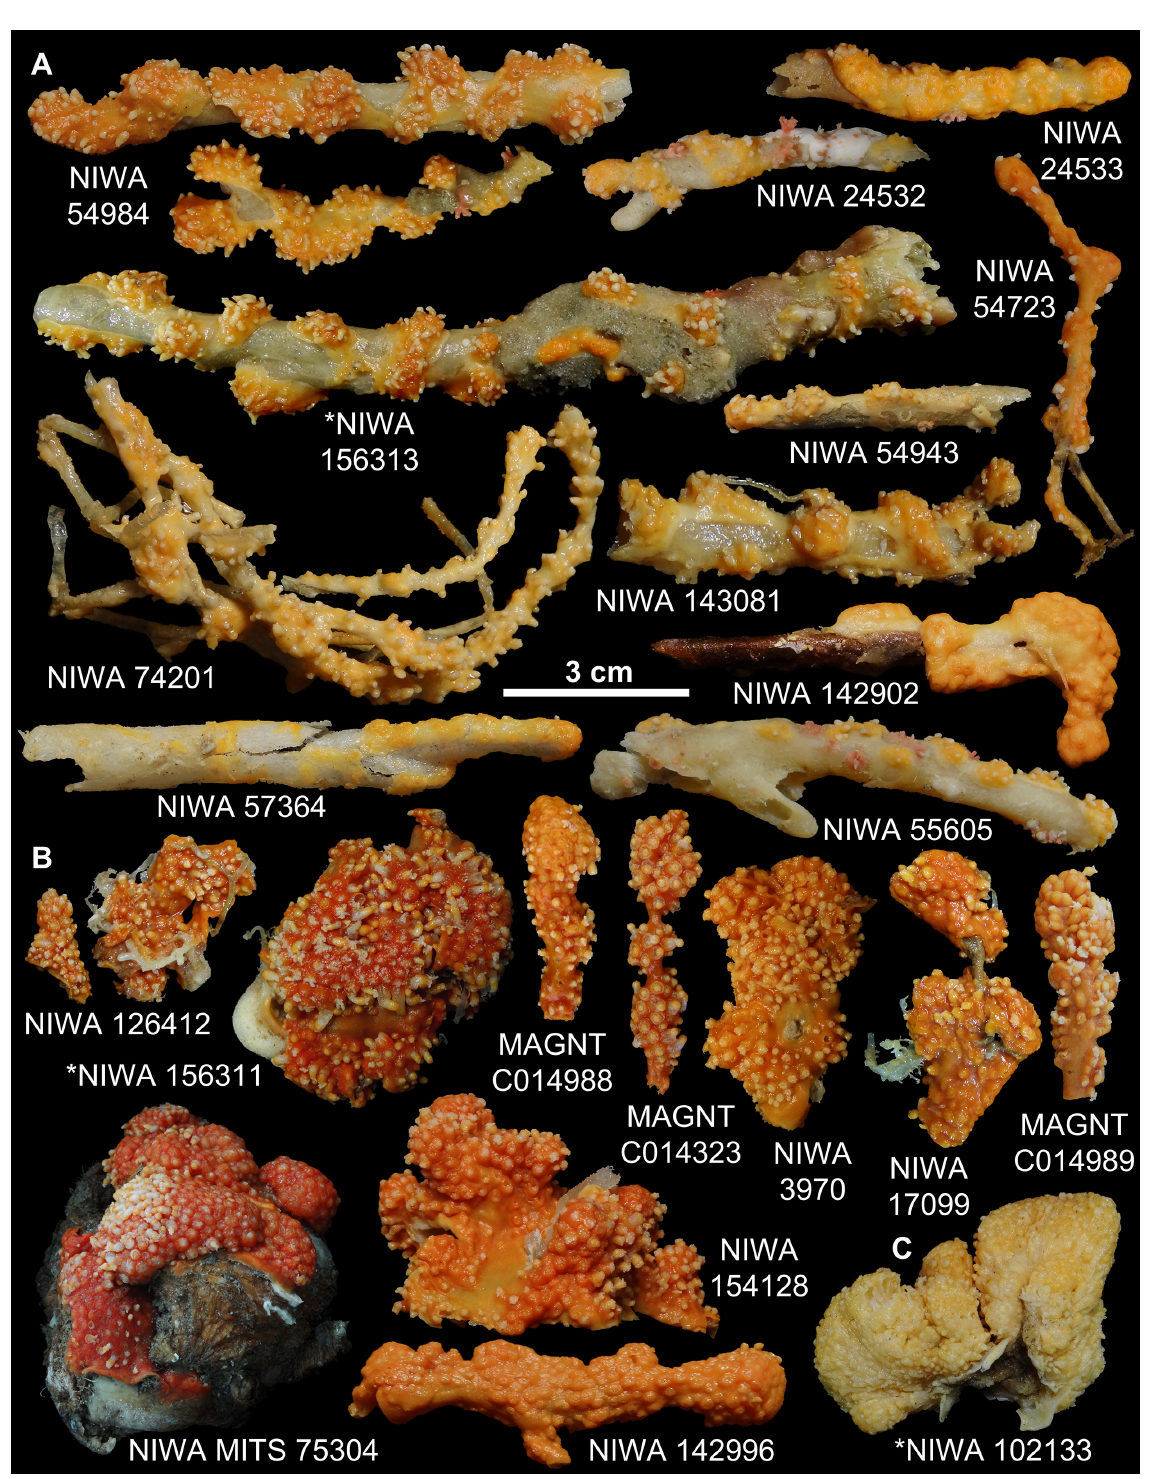
Fig. 28. Selected preserved specimens. A . Ushanaia ferruginea gen. et sp. nov. B . U. fervens gen. et sp. nov. C . U. solida gen. et sp. nov. Note that most specimen lots include additional fragments that are not depicted. * =